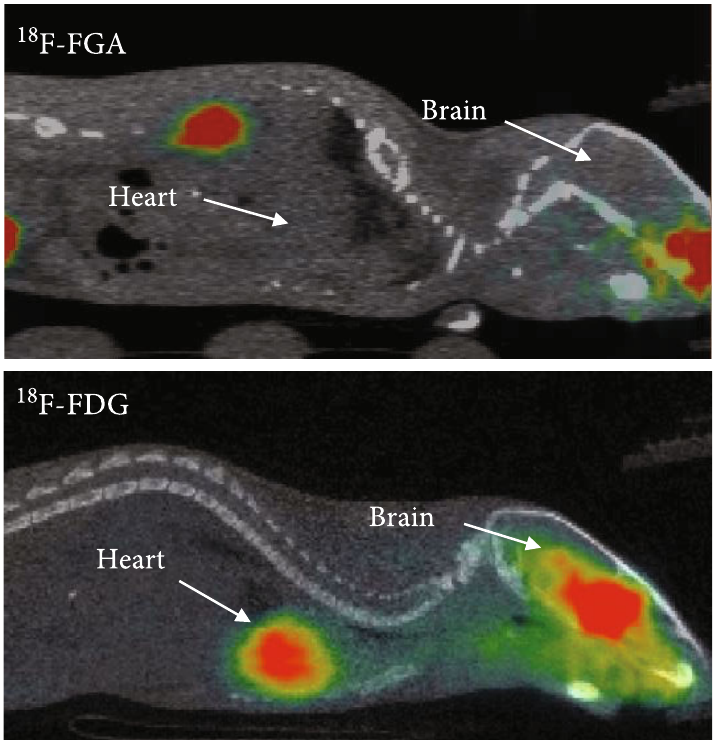
Figure 4: Whole-body images of mice injected with 18 F-FGA and 18 F-FDG. Approximately 10 MBq of 18 F-FGA and 18 F-FDG was intravenously injected in normal mice, and PET images were acquired after 30 min of injection. Whereas 18 F-FGA rapidly cleared from circulation via the kidneys and did not show any accumulation in the normal heart and brain, 18 F-FDG was signi fi cantly retained in the heart and brain.